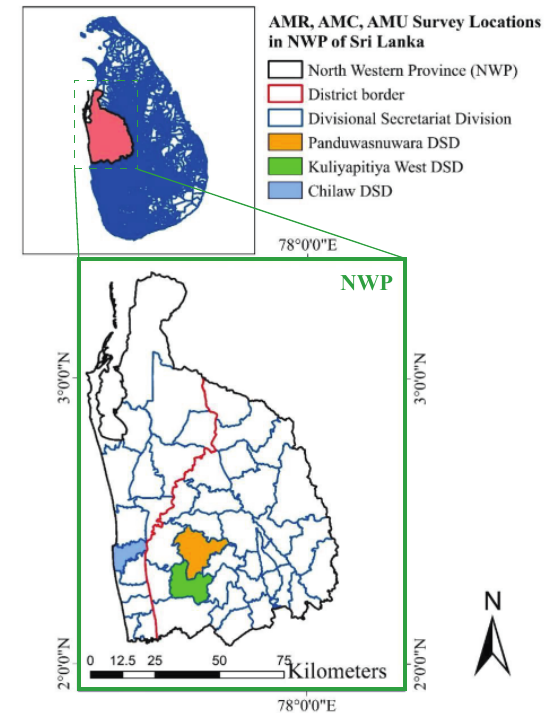
Figure 1. Three divisional secretariats, at Panduwasnuwara, Kuliyapitiya, and Chilaw, were estab- lished for the studies.